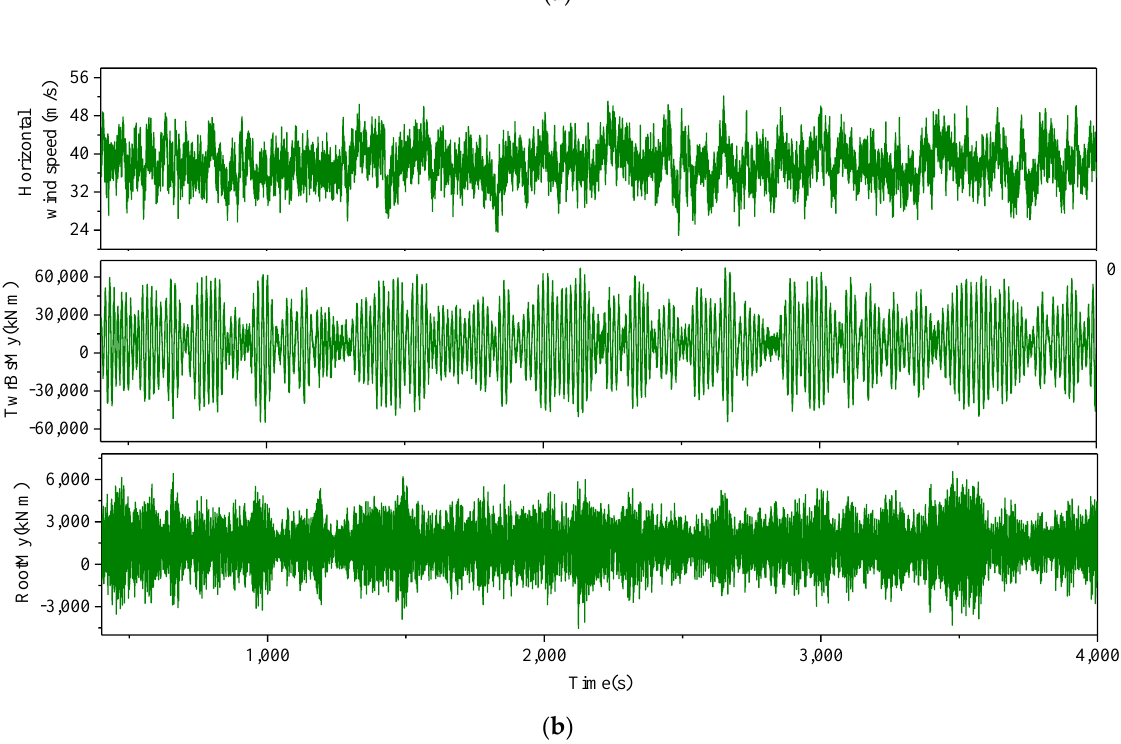
Figure 16. Time histories of responses of the cage and wind turbine under condition 4. ( a ) Cage responses. ( b ) Wind turbine